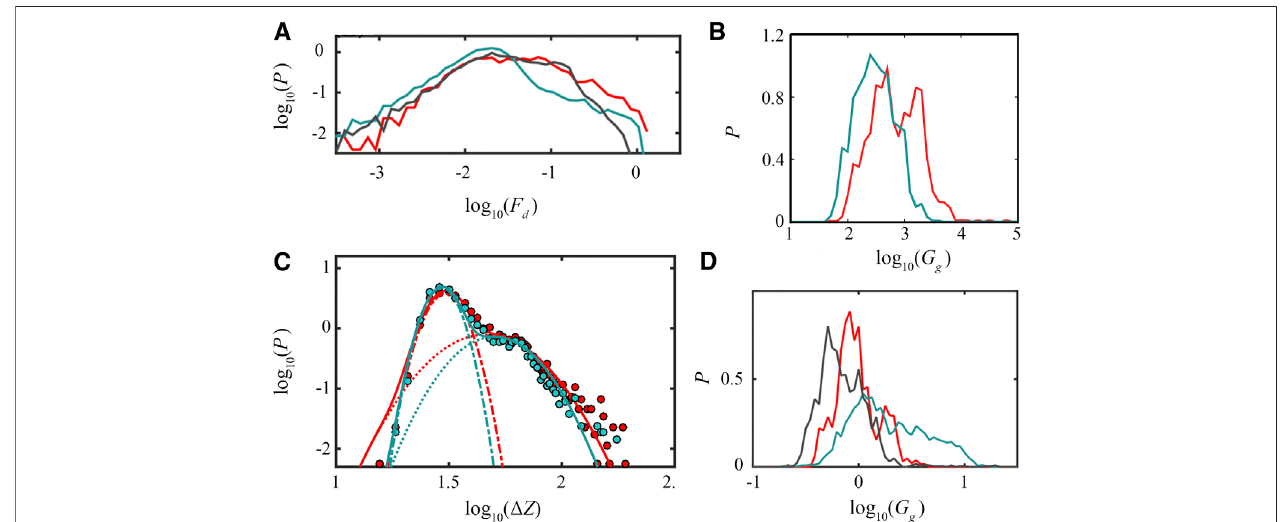
FIGURE 2 | (A) Probability distributions of the logarithm of the local force drops F d ( nN ) estimated from local disruption events collected from sets of myoblasts (red),myotubes(blue)andATPdepletedmyoblasts(black); (B) Probabilitydistributionsofthelogarithmofshearrelaxationmodulus G g ( kPa ) estimatedbyaparabolic fi t of the Force-Indentation Curves (Sneddon model [71]), from healthy (blue) and leukemic (red) immature CD34 + hematopoietic cells; (C) Distribution of the indentation lengths of the rupture events detected from healthy (blue) and leukemic (red) immature CD34 + hematopoietic cells; (D) Probability distributions of the logarithm of shear relaxation modulus G g ( kPa ) on the same sets of cells as in (A) . Note that plots (A) and (C) are in log-log scale and plots (B) and (D) are in semi-log scale. All the logarithms are here in base 10. Panels (A) and (D) are adapted from [67] (B) from [2] and (C) from [2].